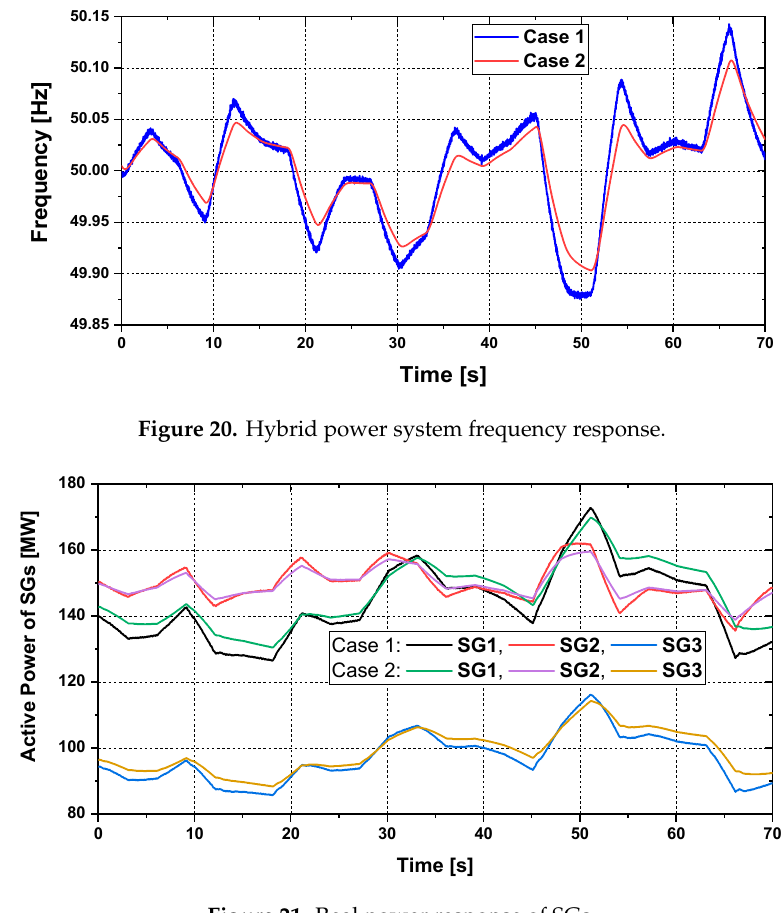
Figure 21. Real power response of SGs.